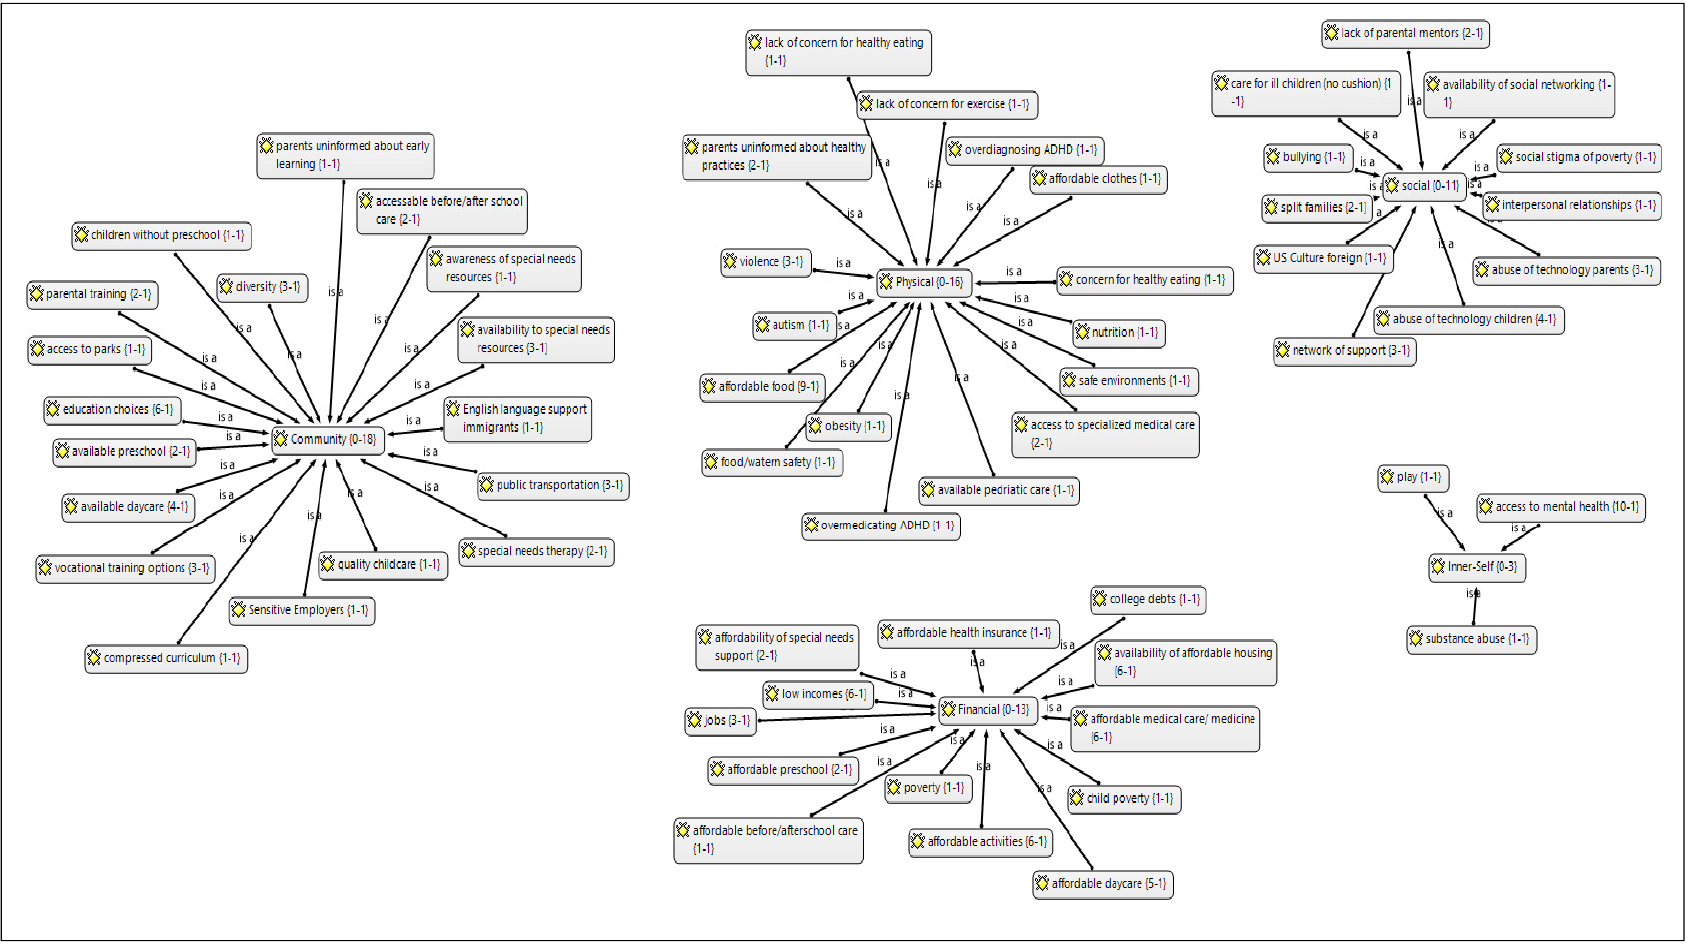
Figure A2. Identified Threats to Well-Being.